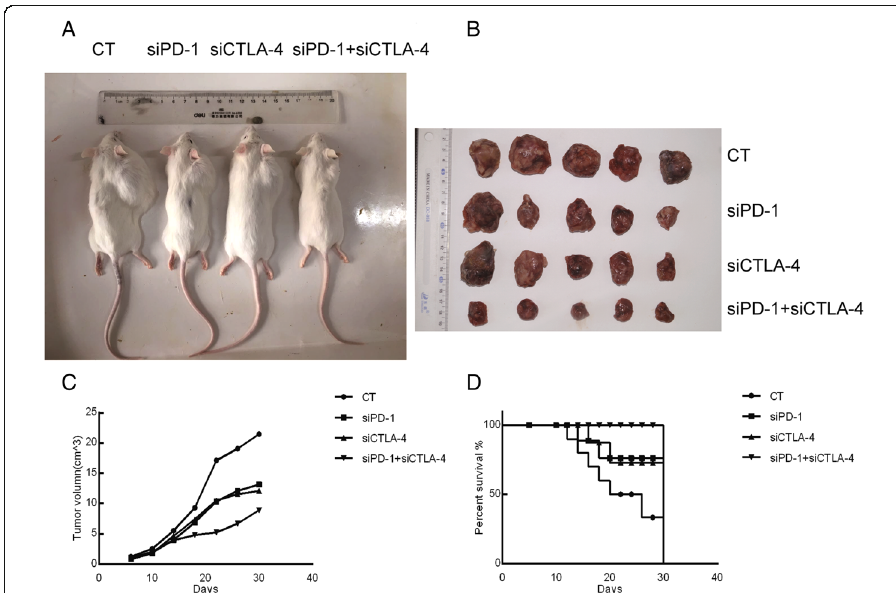
Fig. 1 The antitumor effect of siPD-1 and siCTLA-4 in the H22 allograft. CT = control, siPD-1 = group injected with siRNA for PD-1, siCTLA-4 = group injected with siRNA for CTLA-4, siPD-1 + siCTLA-4 = group injected with siRNA for PD-1 + CTLA-4. a – Photo of four representative tumor-bearing mice (one per group). The picture was taken 30 days after inoculation with H22 cells. b – Photo of 5 solid tumors from each group. Tumors were removed from mice 30 days after inoculation with H22 cells. c – Change curve of tumor volume. Tumor diameter was measured with a caliper once every 4 days for 30 days and volume was calculated as described in section observing the physiological condition of the H22 mice 2.4. d – Survival rate of mice. These results indicate that siRNAs markedly inhibited the growth of